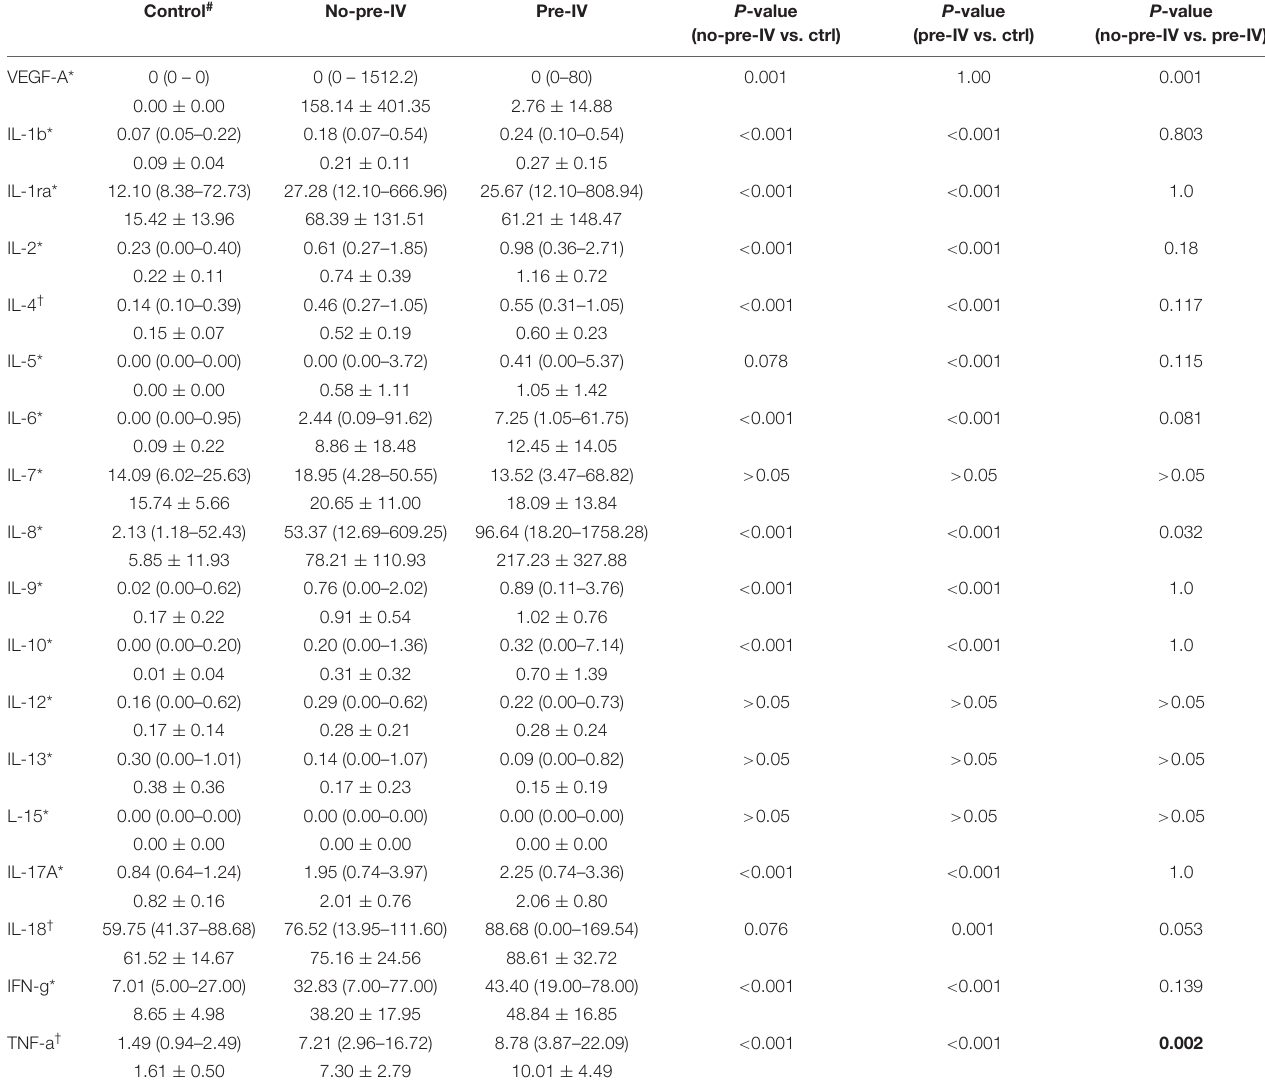
TABLE 2 | Vitreous levels of inflammatory cytokines among the groups of Control, No-Pre-IV, and Pre-IV. Control # No-pre-IV Pre-IV P -value